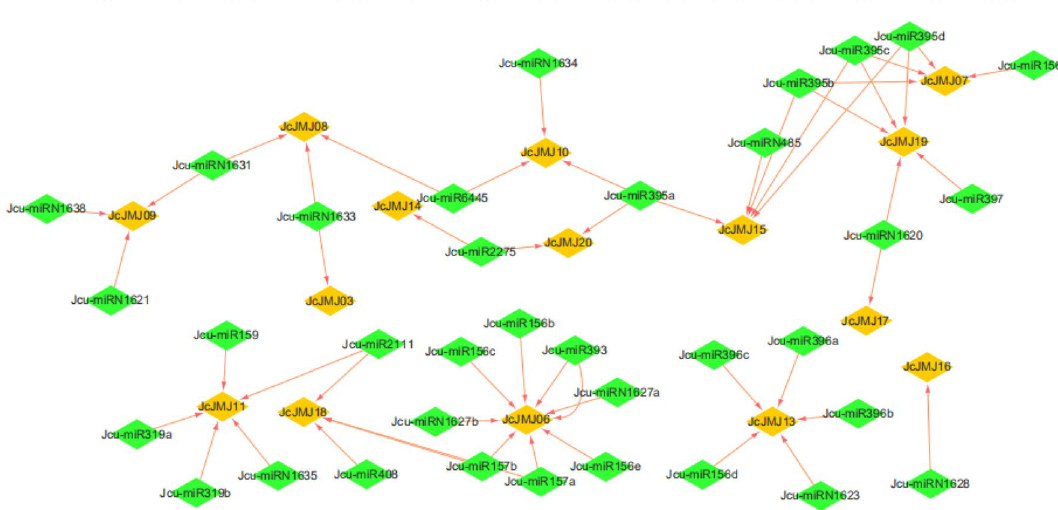
Figure 7. Regulatory networks between the conserved miRNAs and their targeted JcJMJ genes. The green and yellow rectangles represent miRNA and JcJMJs, respectively. The direction of the arrow indicates the direction of the target